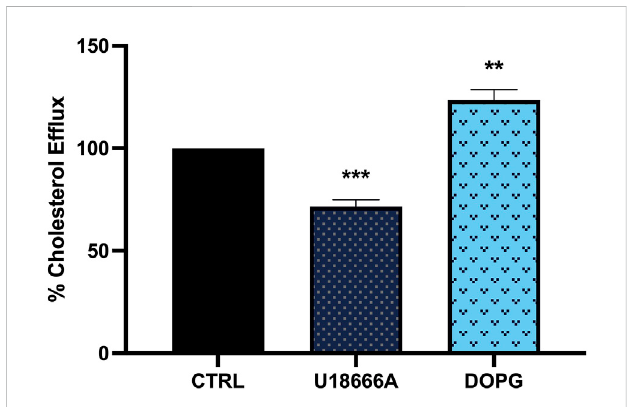
FIGURE 2 DOPG increased cholesterol ef fl ux from BMdM with U18666A decreasing ef fl ux. BMdM were loaded with TopFluor cholesterol (5 μ g/ mL) in serum free RPMI 1640 media. After 24 h, cells were washed and treated with U18666A (10 μ g/mL) for 24 h or DOPG for 1 h in complete media. TopFluor fl uorescence intensity measured in supernatants after 24 h. Data expressed as mean ± SEM , n = 4. Analyzed by one-way ANOVA with Dunnett ’ s multiple comparisons test. ** p < 0.01 and *** p < 0.001 compared to untreated control